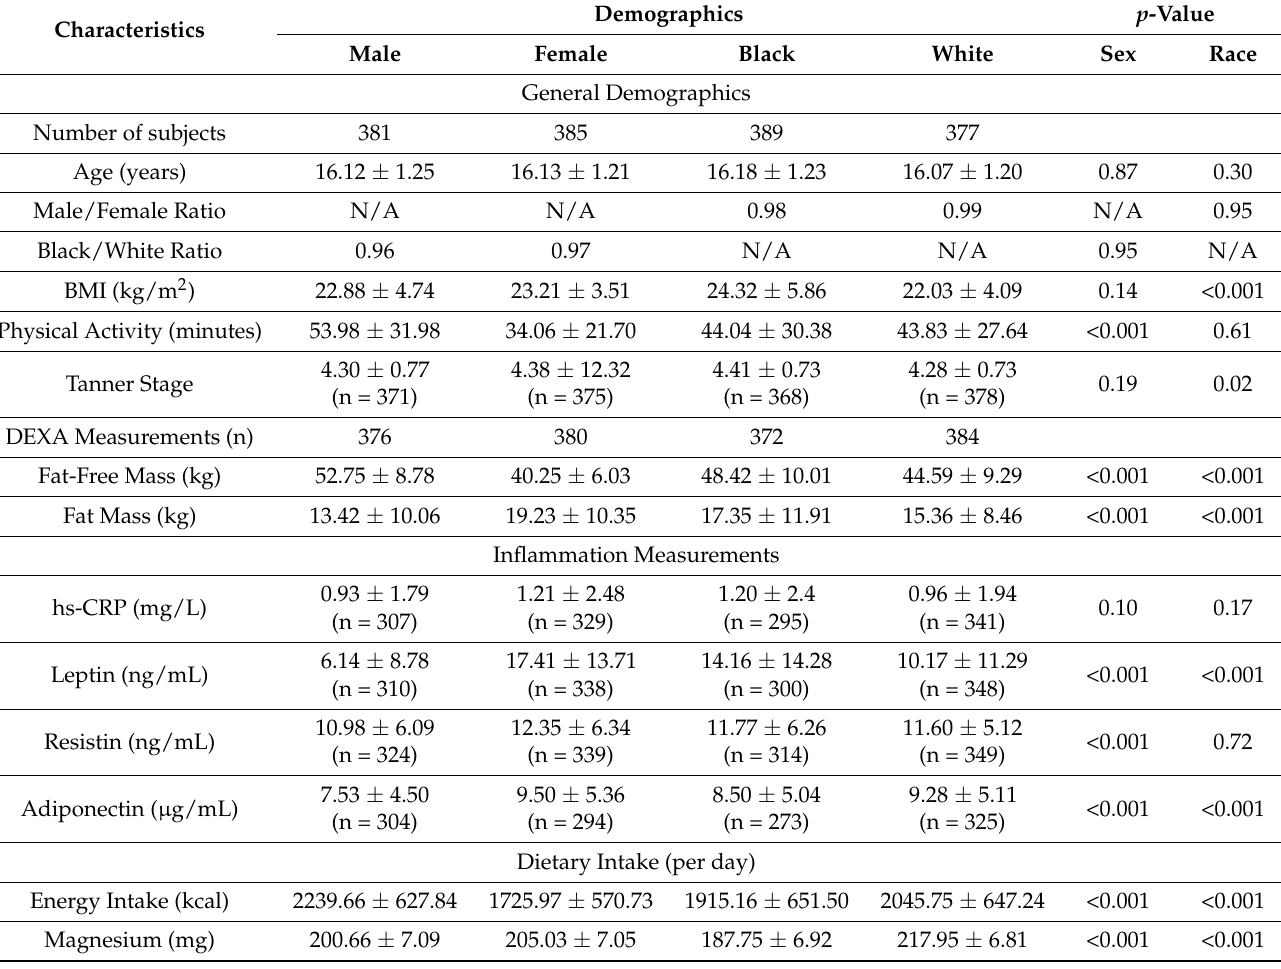
Table 1. General characteristics by sex and